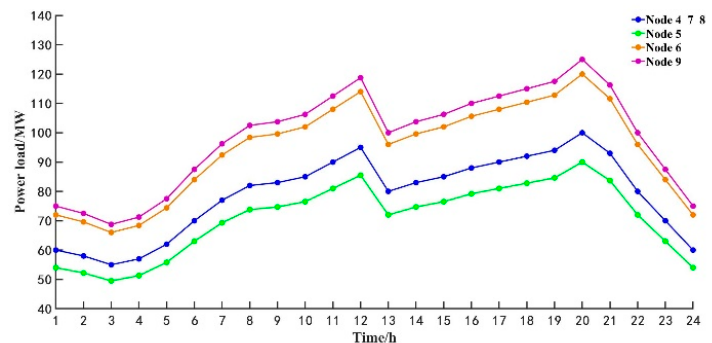
Figure A1. Typical daily power load for planning.